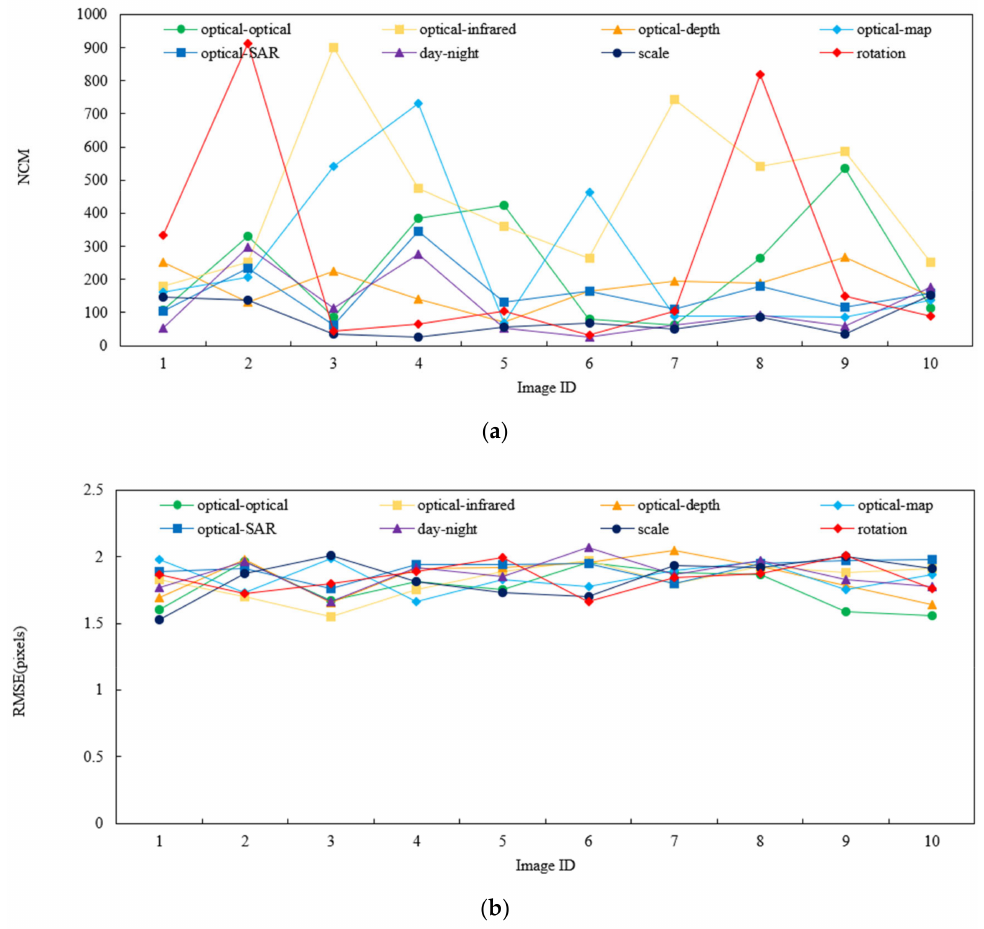
Figure 12. Coarse matching results of G-CoFTM on the NCM ( a ) and RMSE metrics ( b ). Table 8. The average results of NCM and RMSE in Figure 12 for each type of image